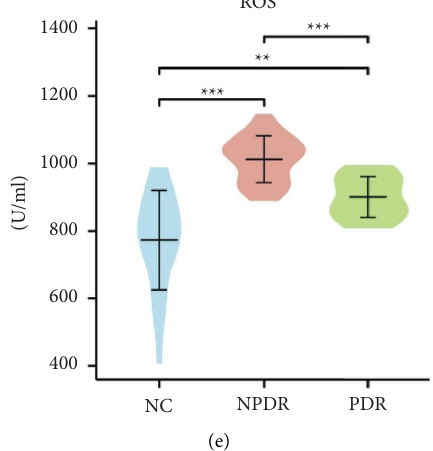
Figure 1: Concentration of ferroptosis-related biomarkers in NC, NPDR, and PDR groups. (a) GPX4 concentration in three groups; (b) GSH concentration in three groups; (c) LPO concentration in three groups; (d) Fe concentration in three groups; (e) ROS concentration in three